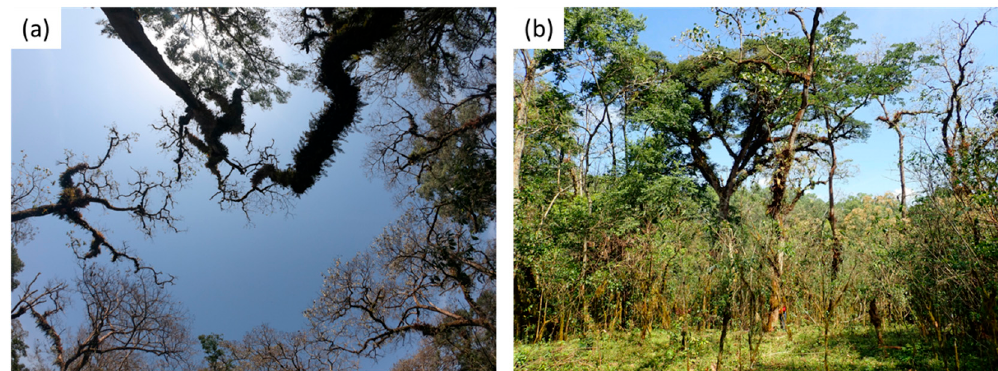
Figure 13. Photos taken at the adjusted tie-point for HMCF for the 1999–2019 period ( T H99a ); ( a ) canopy cover and ( b ) surrounding area.